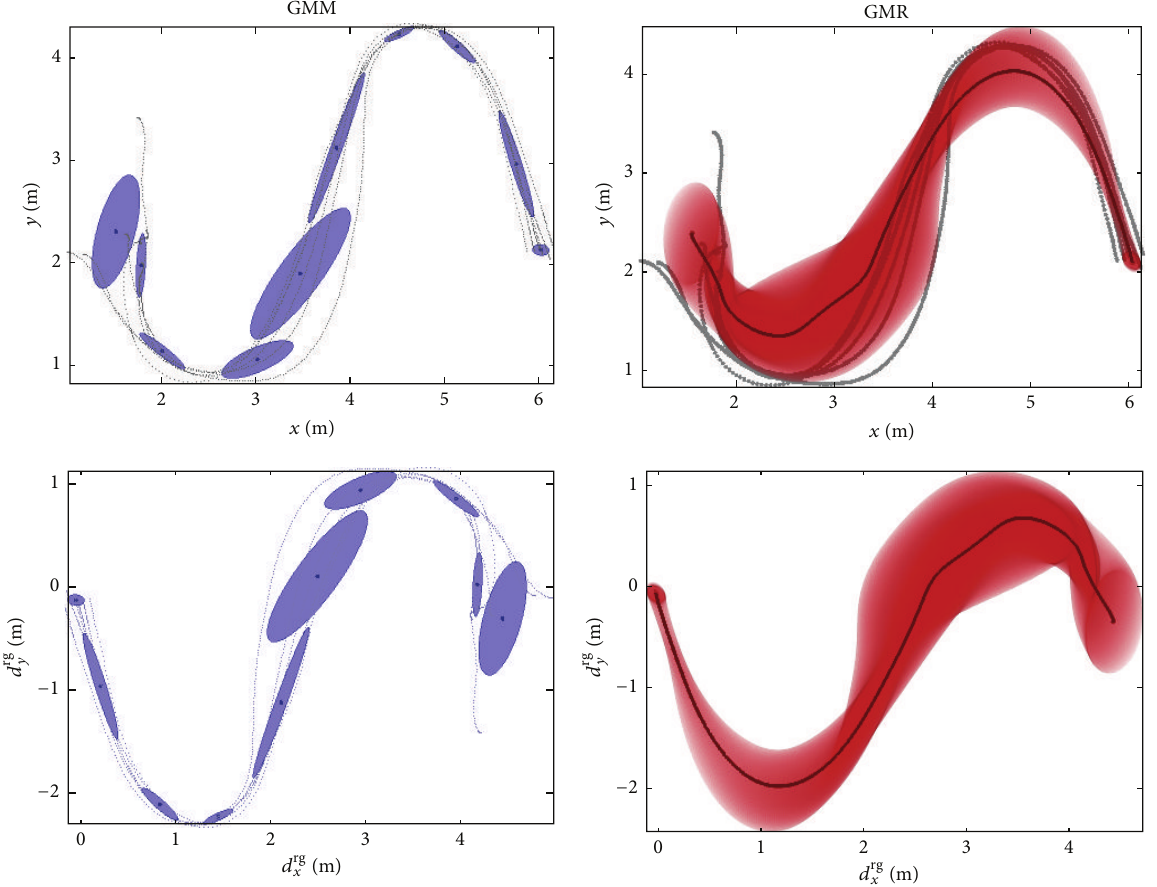
Figure 9: Trajectory encoding and retrieval using GMM and GMR for variables 𝑥 and 𝑑 in task